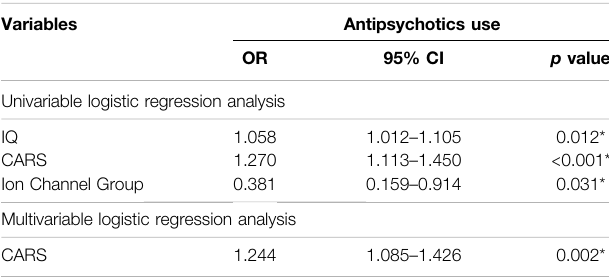
TABLE 3 | Logistic regression analysis for antipsychotics use in ASD.